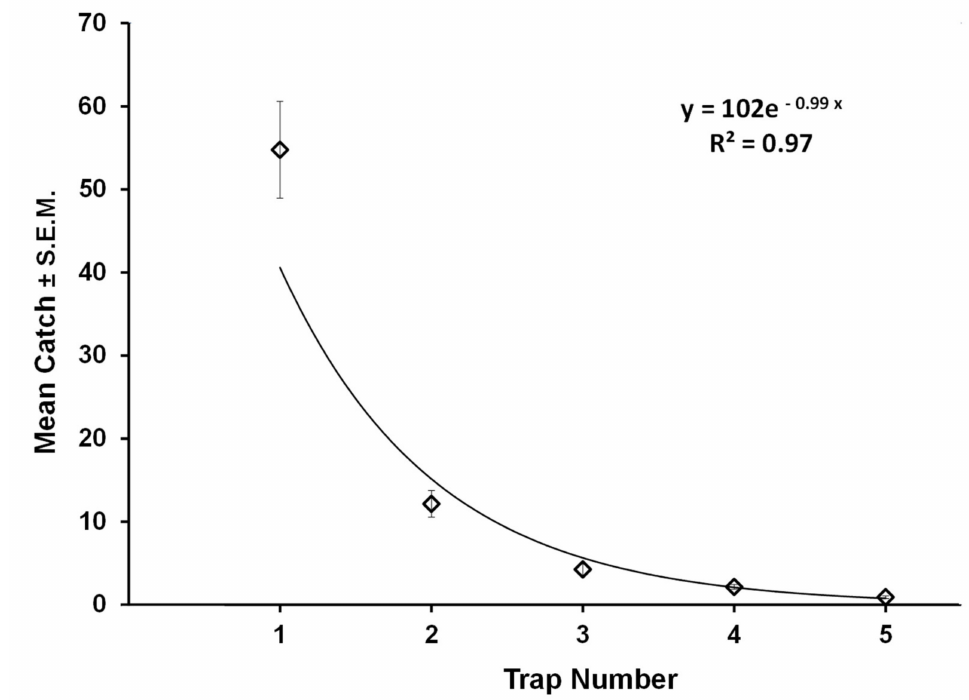
Figure 5. Decay curve averaged across all 39 replicates of codling moth males penetrating a 5 × 5 grid of traps in the field. An exponent of negative 0.99 equates to a circular standard deviation (c.s.d.) of 37 ◦ .